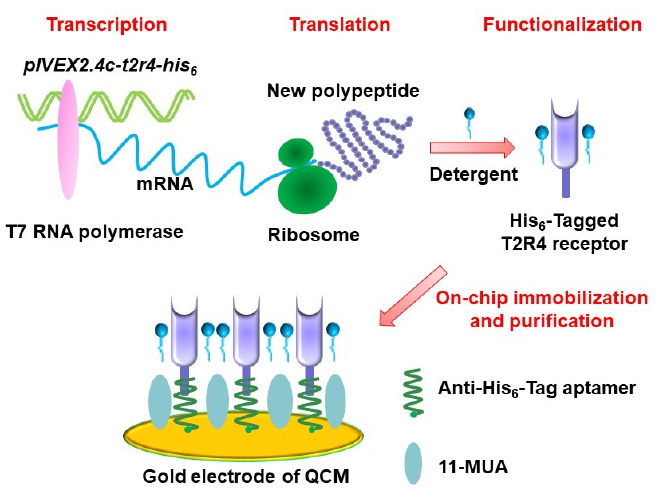
Figure 2. Schematics of preparation of a bitter receptor from cell-free protein expression system for chemical sensing. (Reprinted with permission from ref. [64]. Copyright 2020